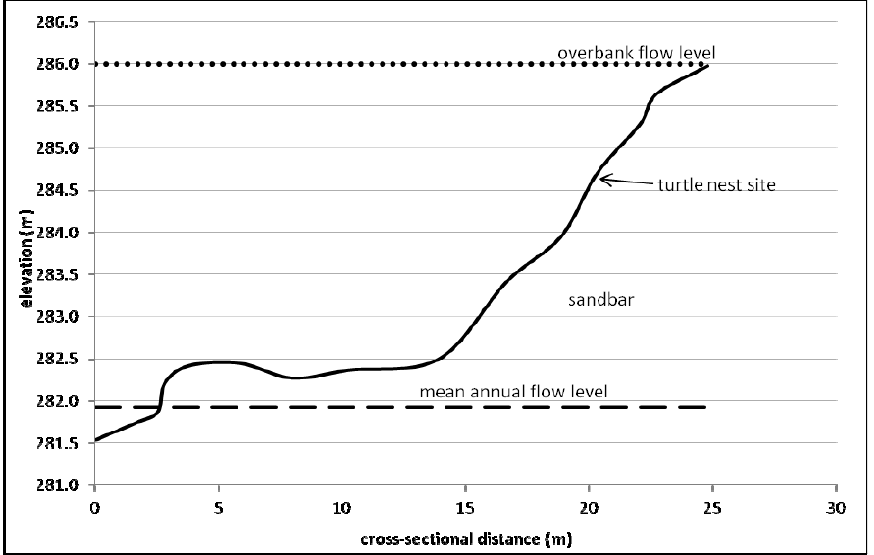
Figure 4. Cross-section of a sandbar on the Kettle River from the turtle survey. Sandbars on the Kettle River were above the mean annual flow level in many cases. At this survey location, turtle nest sites were found high on the sandbar, well above the mean annual flow level.